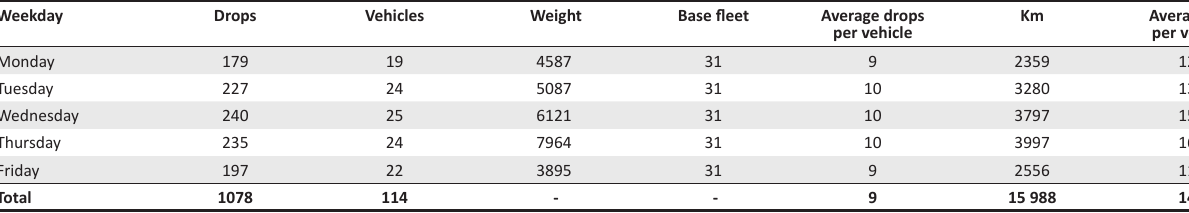
TABLE 7: Distribution centre 3 plan case study optimisation results.